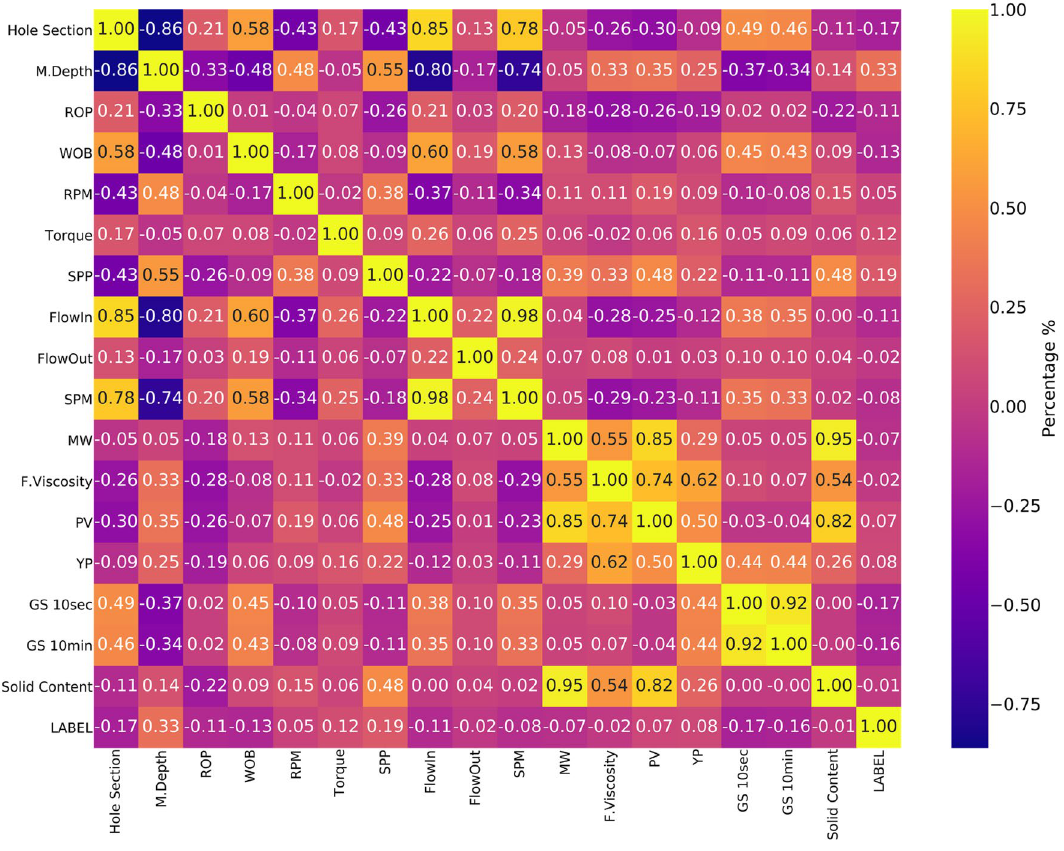
Fig. 9 HeatMap correlation plot